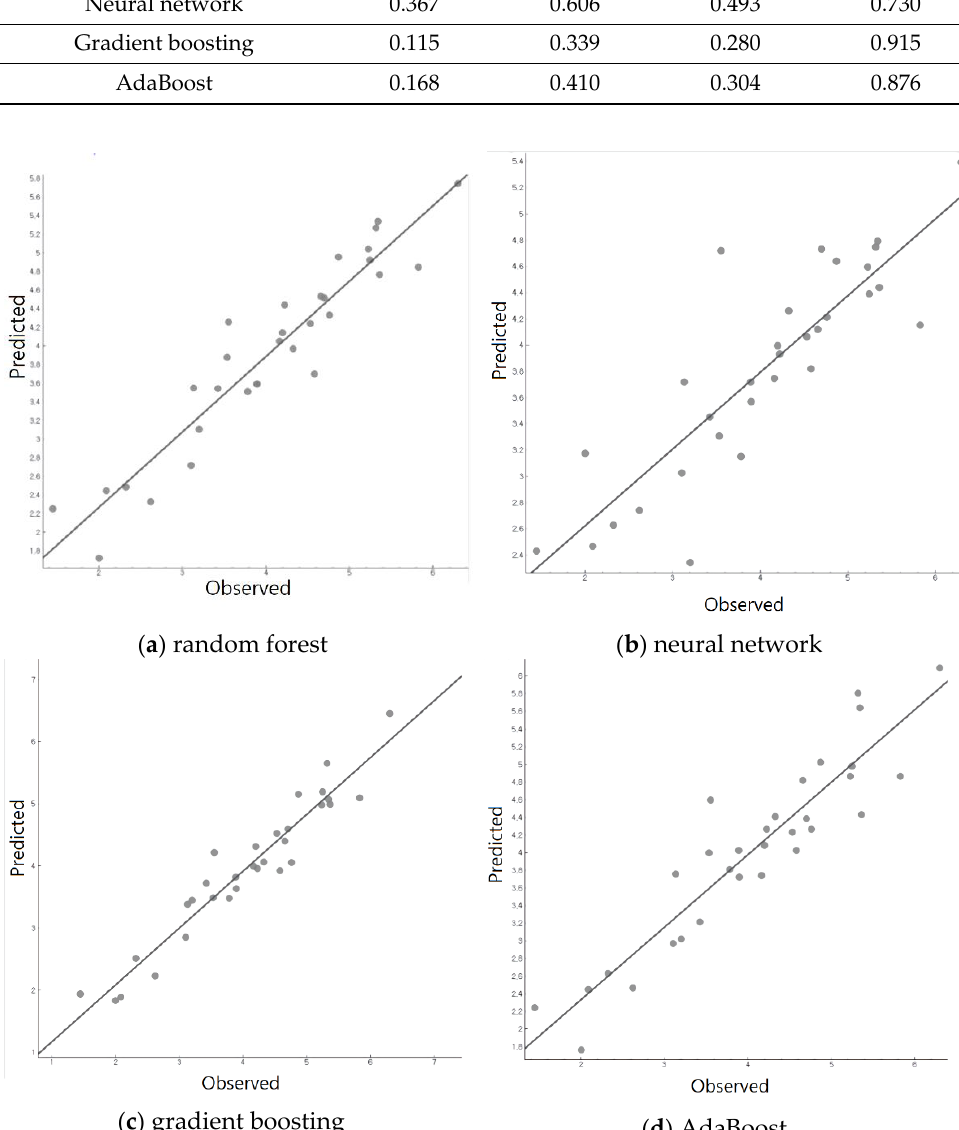
Figure 12. Predicted vs observed data in model Figure 12 . Predicted vs observed data in model developed.